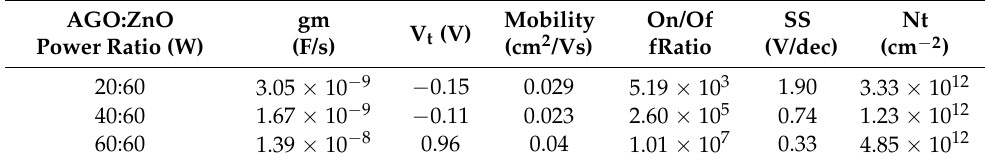
Figure 4. ( a ) Transfer characteristics of AGZO TFT with different power ratio. XPS analysis of the AGZO thin film with different power ratios of ( b ) 20:60; ( c ) 40:60 and ( d ) 60:60. Table 2. Characteristics of AGZO TFT with different power